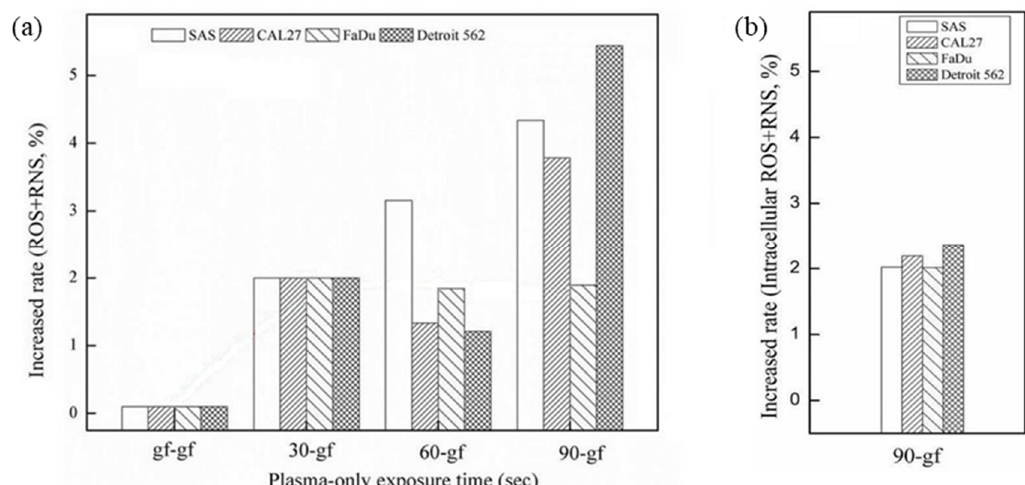
Figure 7. ( a ) By integrating the increased rates of ROS+RNS content with respect to plasma-only exposure time (minus the reference, on the medium with the cells under gas flow), their increased rates are presented. ( b ) By integrating the increased rates of intracellular ROS+RNS with respect to plasma-only exposure time of 90 s, their relationship is presented.